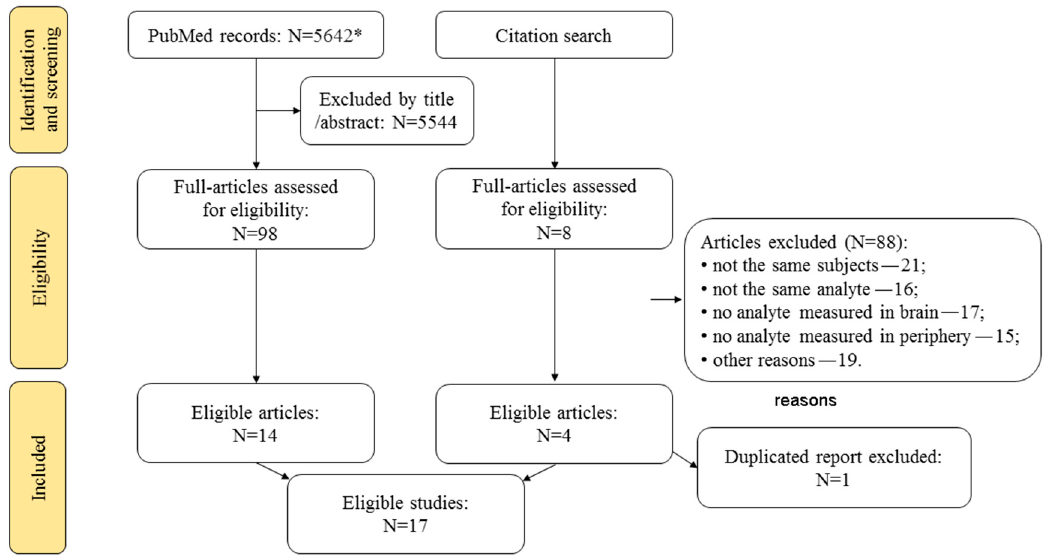
Figure 1. Search of the published studies eligible for the systematic review. * Includes publications of interest already known to the authors.